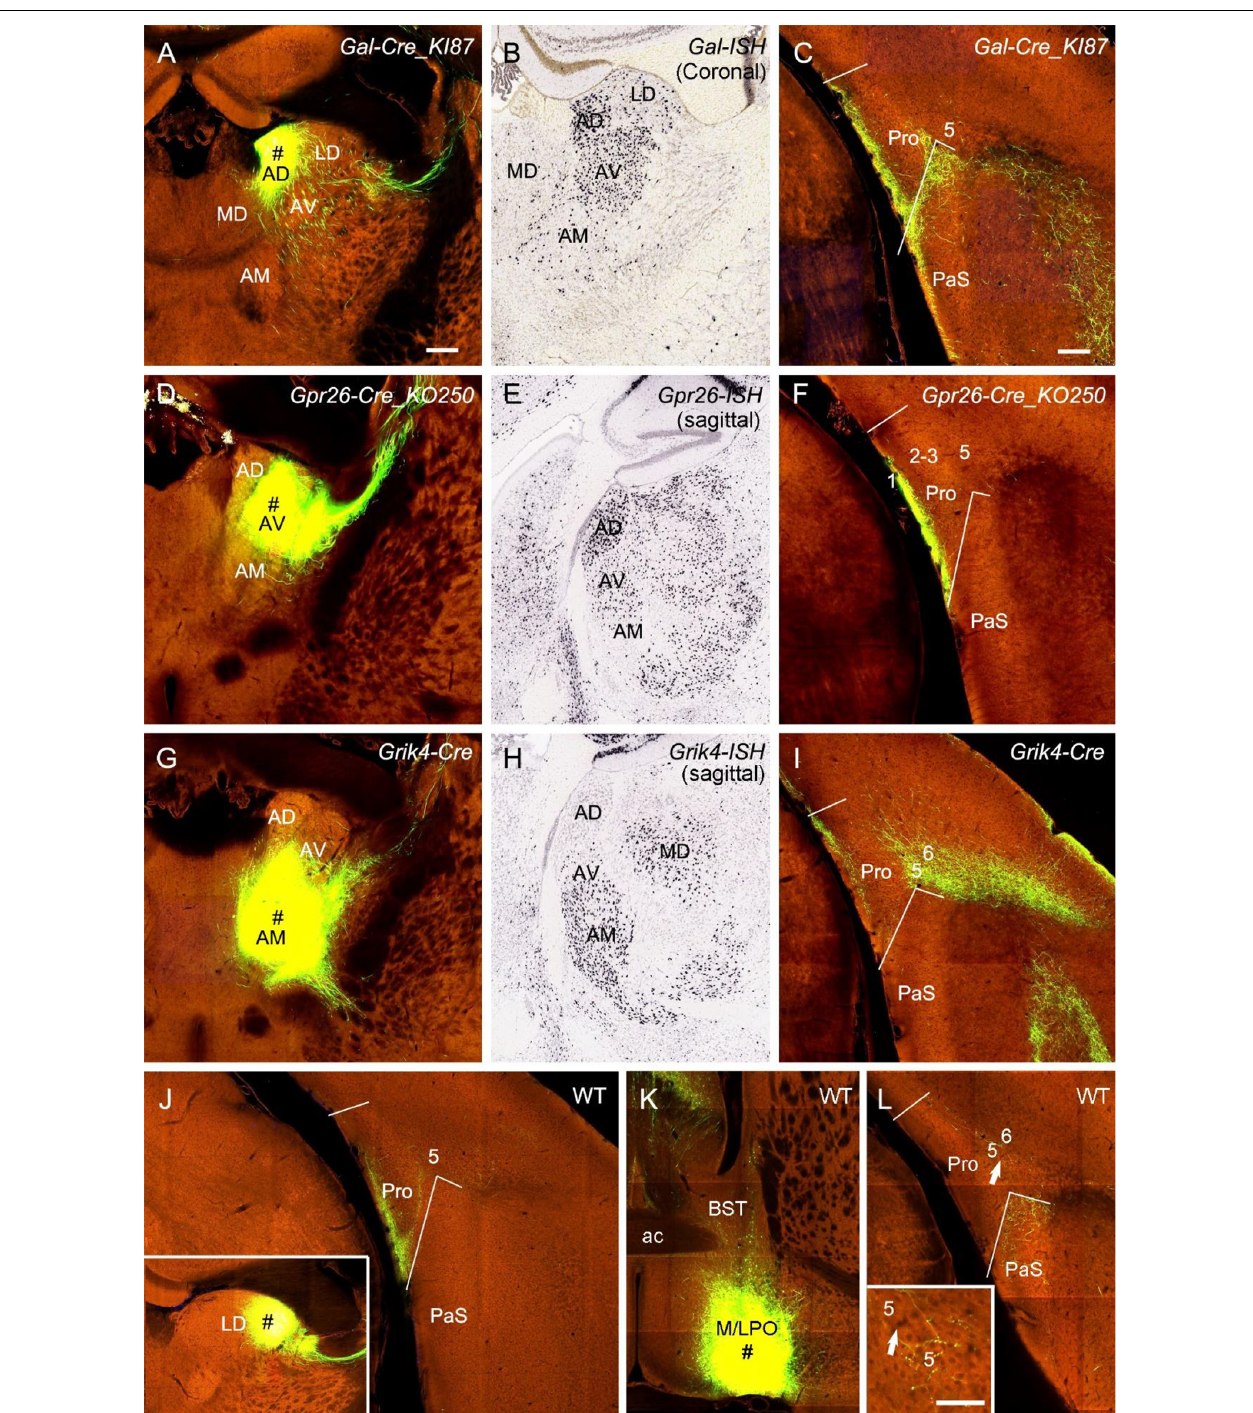
FIGURE 10 | Projections from thalamic and hypothalamic regions to the Pro. (A–C) An injection in the anterodorsal nucleus (AD; # in A ) of a Gal -Cre_KI87 mouse, in which strong Gal -Cre expression is seen in AD and AV ( B , for ISH), leads to strong terminal labeling in L1 of the Pro (C) . ( D–F) An injection in the anteroventral nucleus (AV; # in D ) of a Gpr26 -Cre_KO250 mouse, in which strong Gpr26 -Cre expression is seen in AD and AV ( E , for ISH) and produces strong terminal labeling in L1 of the Pro (F) . (G–I) An injection in the anteromedial nucleus (AM; # in G ) and AV of a Grik4 -Cre mouse, in which strong Grik4 -Cre expression is seen in AM and AV ( H , for ISH), results in strong terminal labeling in L1 and L5–6 of the Pro (I) . (J) Strong terminal labeling in L1 of the Pro after an injection was contained in the laterodorsal nucleus (LD; # in the inset) of a WT mouse. (K,L) An injection in the preoptic region of the hypothalamus (M/LPO; # in K ) of a WT mouse results in weak terminal labeling in L5 of the Pro (L) , which is magnified in the inset. The arrows point to the same location. Bar: 350 µ m in (A) (for all panels); 70 µ m in the inset in (L) .